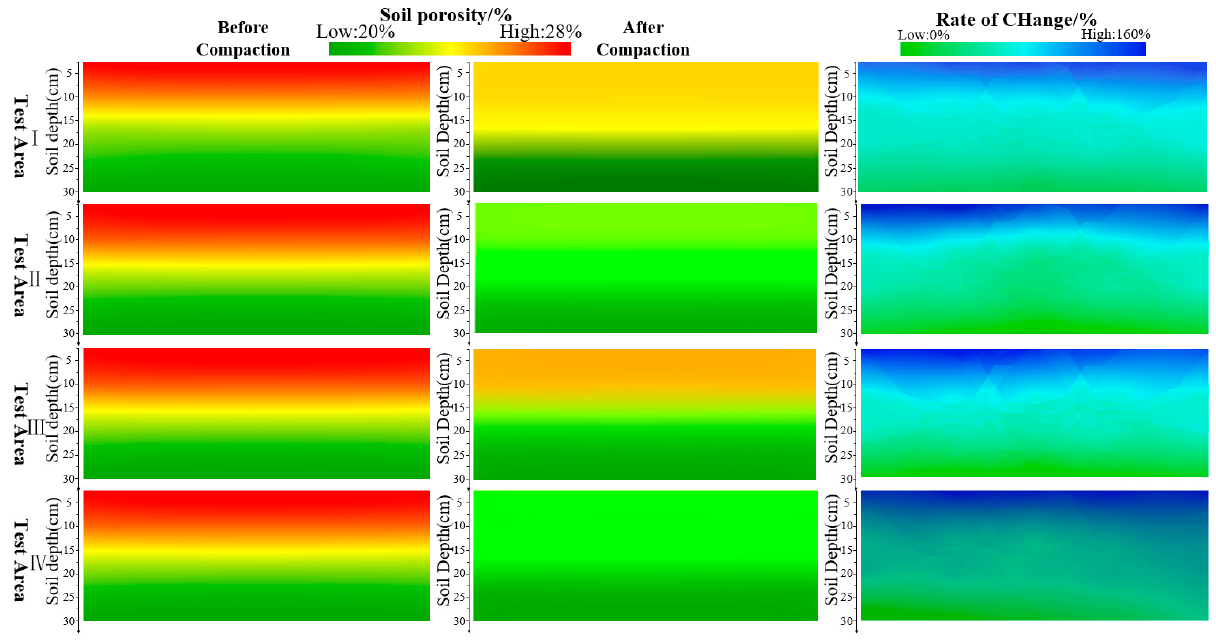
Figure 8. Soil longitudinal porosity clouds before and after compaction in each test area .